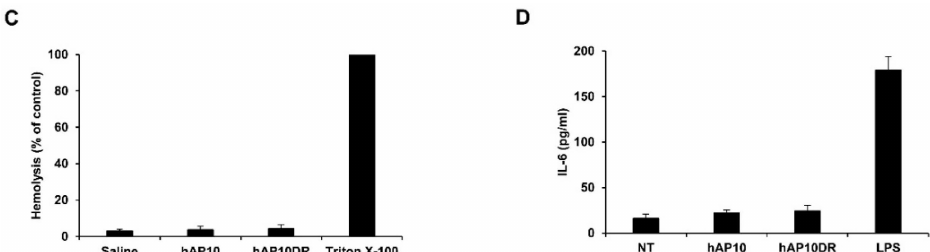
Figure 4. Lack of toxicity and immunogenicity of hAP10 and hAP10DR. ( A ) The indicated cells were exposed to increasing concentrations of hAP10 or hAP10DR for 20 h. Viability was then assessed by an MTT assay. Data are means ± s.e.m. ( n = 3). ( B ) Necrotic cell death was monitored by lactate dehydrogenase (LDH) release from cells into the culture medium. The obtained values were normalized to those of the maximum LDH released (completely lysed) control. Data are means ± s.e.m. ( n = 3). ( C ) hAP10 and hAP10DR do not induce hemolysis in vitro. Mice red blood cells were incubated with 30 µ M of hAP10 or hAP10DR. Released hemoglobin was detected by densitometry at 540 nm. Hemoglobin release by cells treated with 1% Triton X-100 was used as 100% lysis control. ( D ) Levels of IL-6 secretion from RAW 264.7 cells exposed to 10 µ M of hAP10 or hAP10DR or LPS (1 µ g / mL) for 24 h.